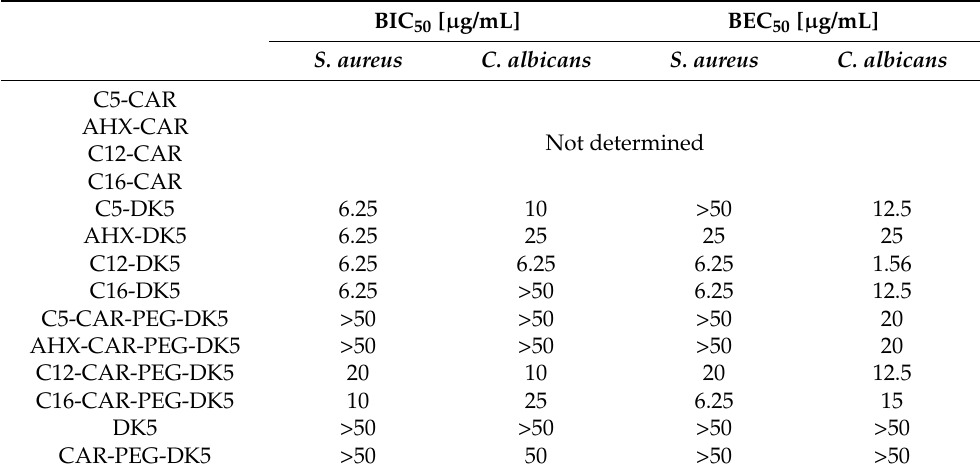
Table 5. The calculated values of BIC 50 and BEC 50 established against S. aureus and C. albi- cans